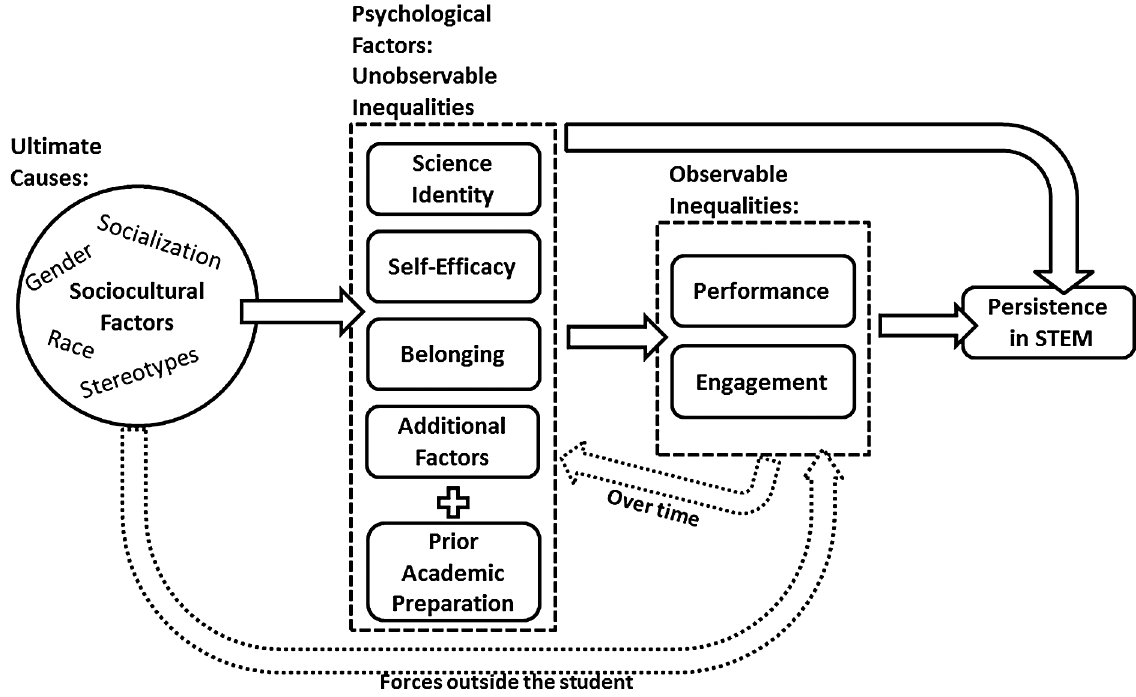
FIG. 1. Model describing how gender gaps in affective and observational measures can impact persistence in STEM and the underlying sociocultural factors influencing all of them. Modified from Wang and Degol ’ s [87] model for understanding career